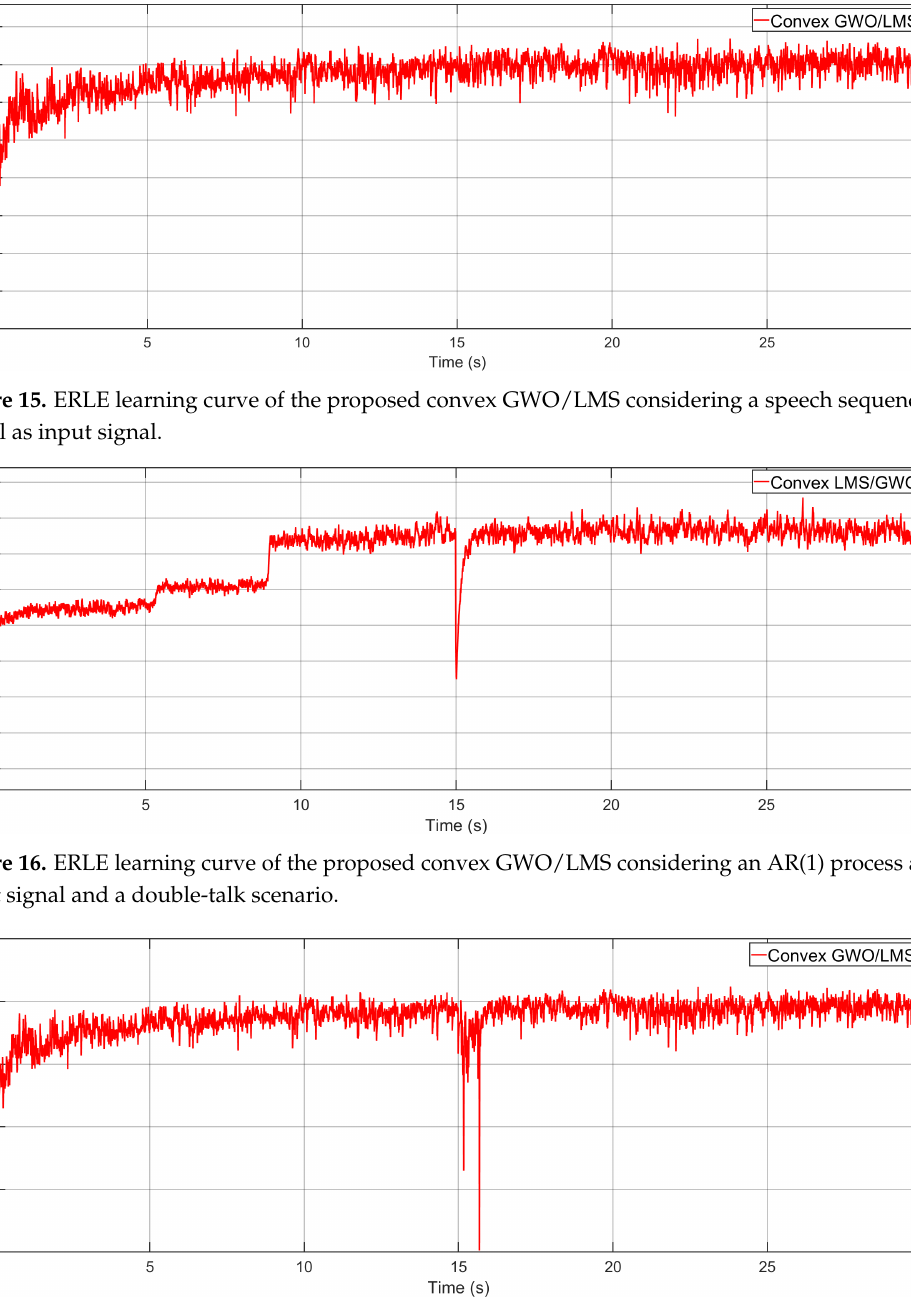
Figure 17. ERLE learning curve of the proposed convex GWO/LMS considering a speech sequence signal as input signal considering a double-talk